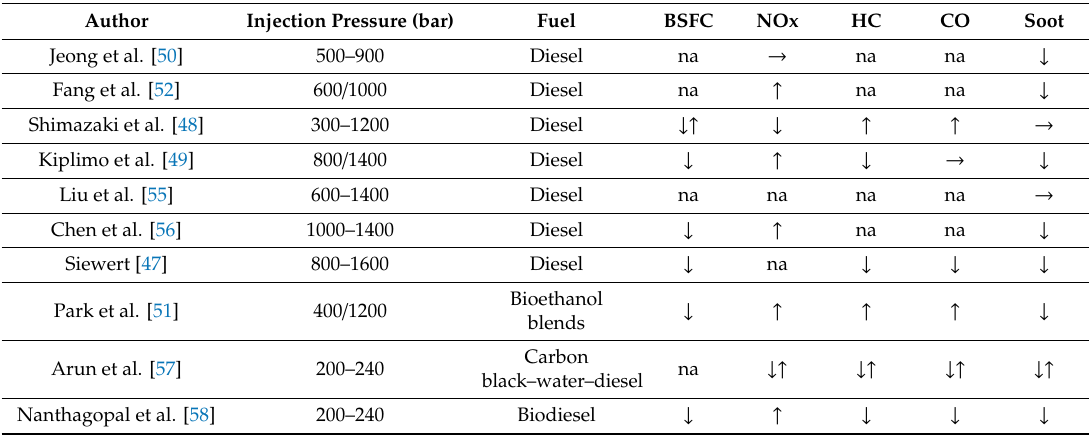
Table 2. Variation of performance and emissions after increasing the injection pressure. BSFC, brake-specific fuel